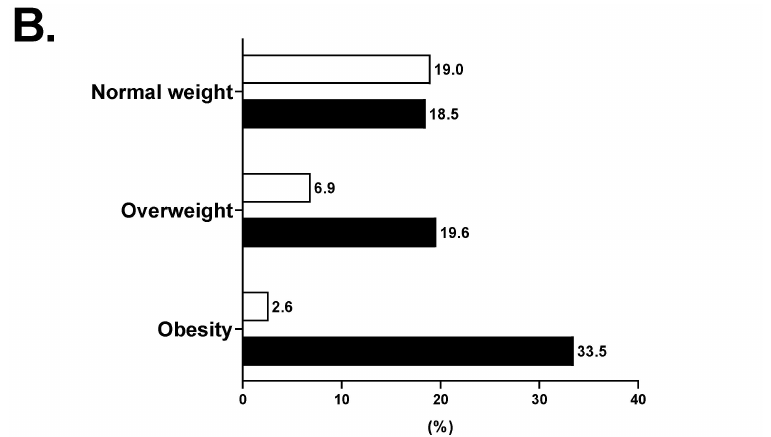
Figure 1. Prevalence of different body phenotypes across categories of weight and metabolic status: based on new definition ( A ) and based on the National Cholesterol Education Program–Adult Treatment Panel III (NCEP-ATPIII) criteria (NCEP definition) ( B ).